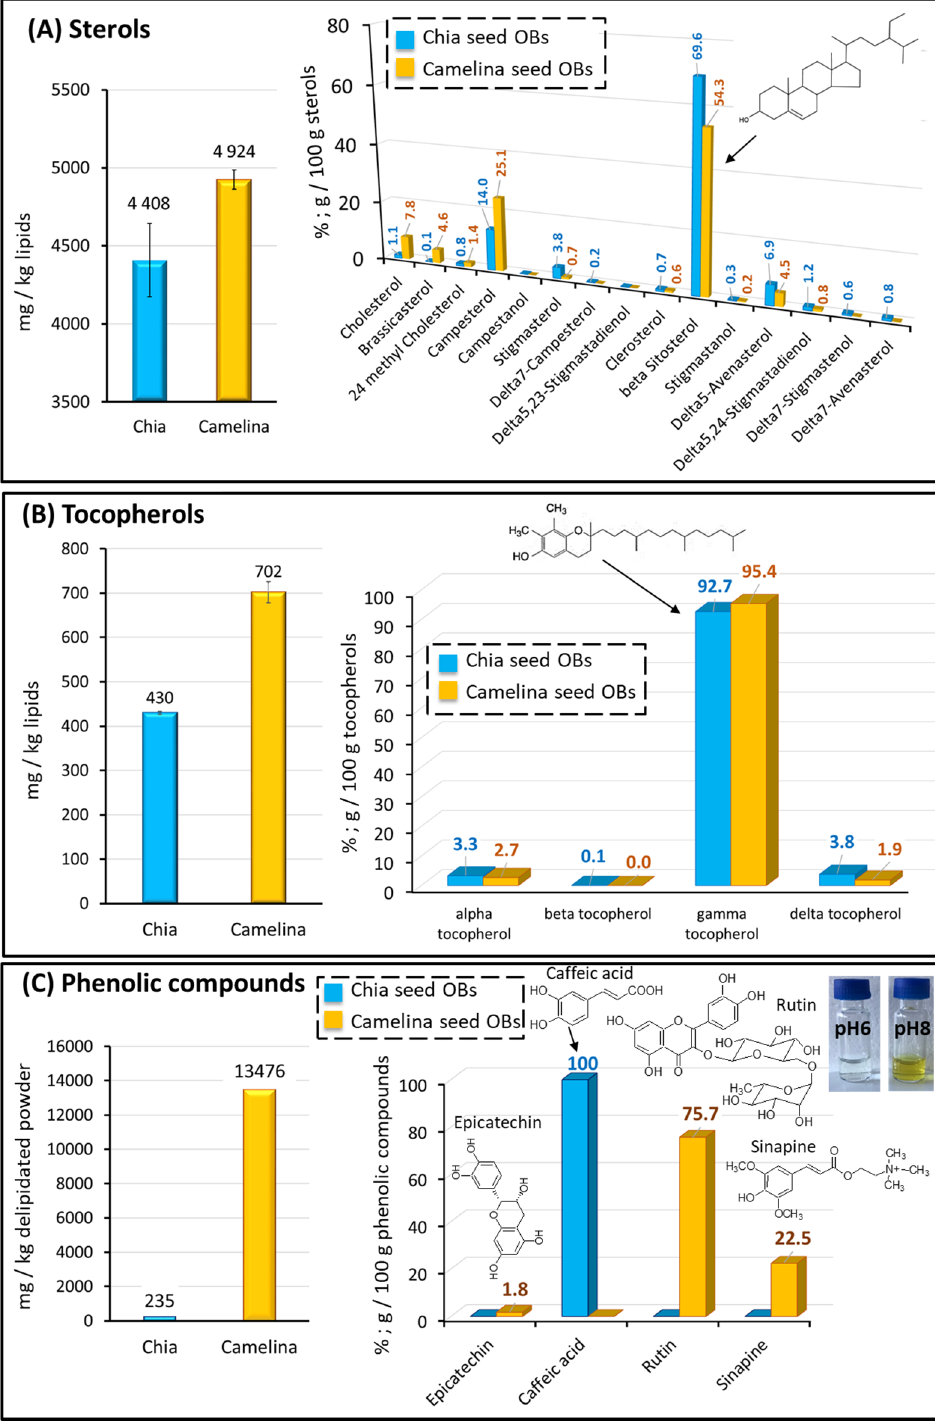
Figure 7. Composition of chia and camelina seed oil bodies: ( A ) sterols, ( B ) tocopherols, ( C ) phenolic compounds, with an illustration showing the yellow colour of rutin at basic pH. The chemical structures of the main components are indicated in the figures.